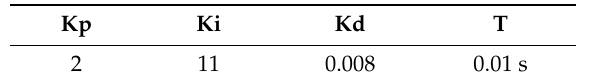
Table 2. Gains from proportional–integral–derivative (PID) DC motor